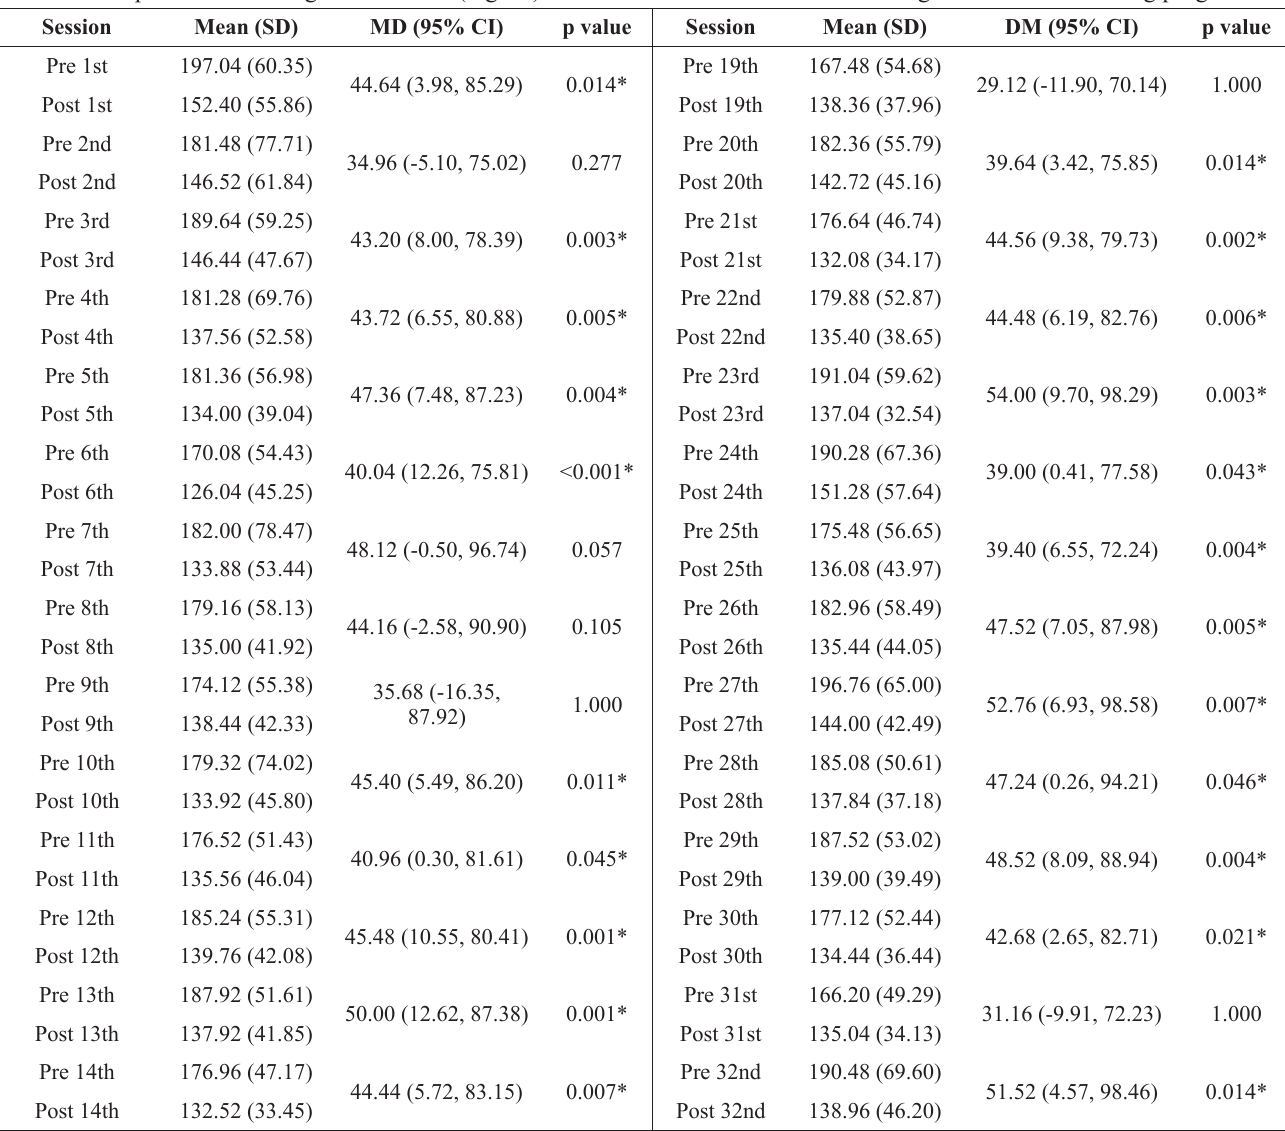
Table 2 . Comparison of blood glucose values (mg/dL) before and after each session of strength and aerobic training